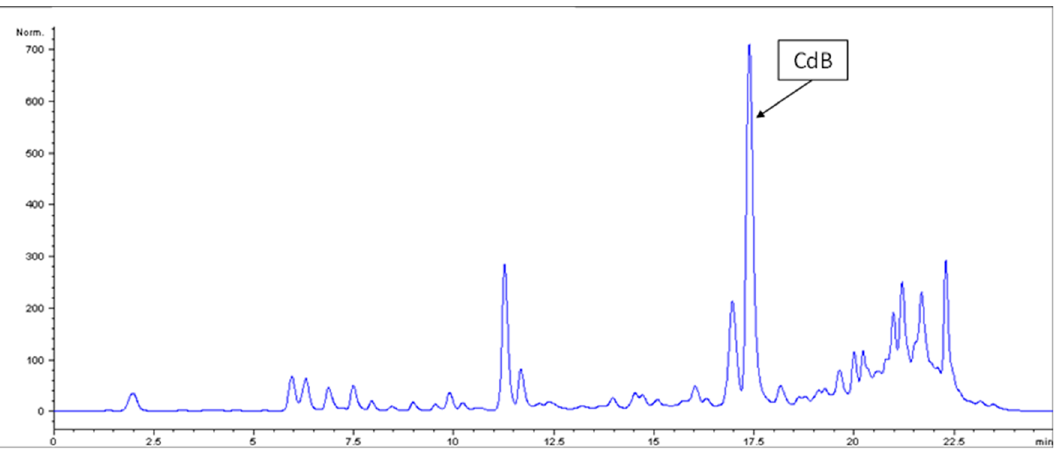
Figure 2. HPLC-FLD chromatogram of sardines in oil (S25) containing the highest concentration of CdB quanti fi ed (2623 µg/kg).